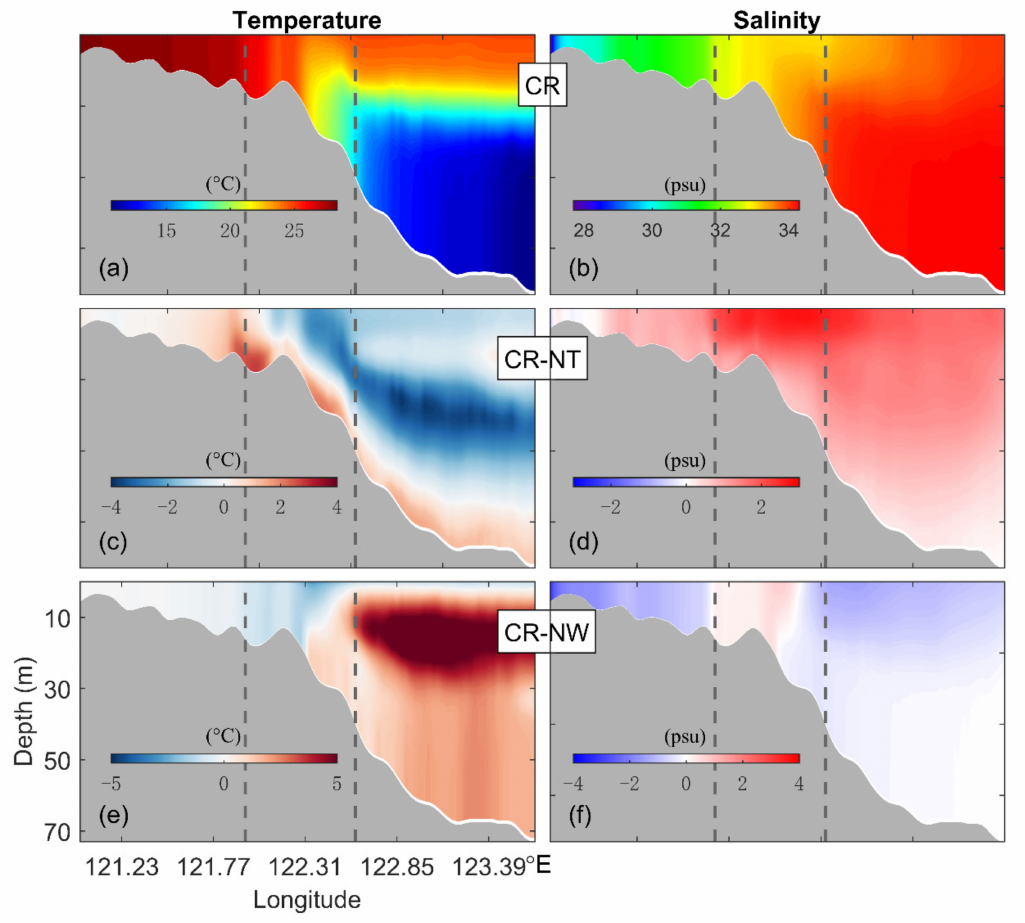
Figure 17. Same as Figure 16 except for in August 2015. Vertical distribution of the simulated monthly mean temperature ( a ) and salinity ( b ) at transect HP (shown in Figure 5) based on the inner model results in the case of CR in August 2015, and differences in the simulated monthly mean temperature ( c , e ) and salinity ( d , f ) at transect HP between cases CR and NT and between cases CR and NW in August 2015,